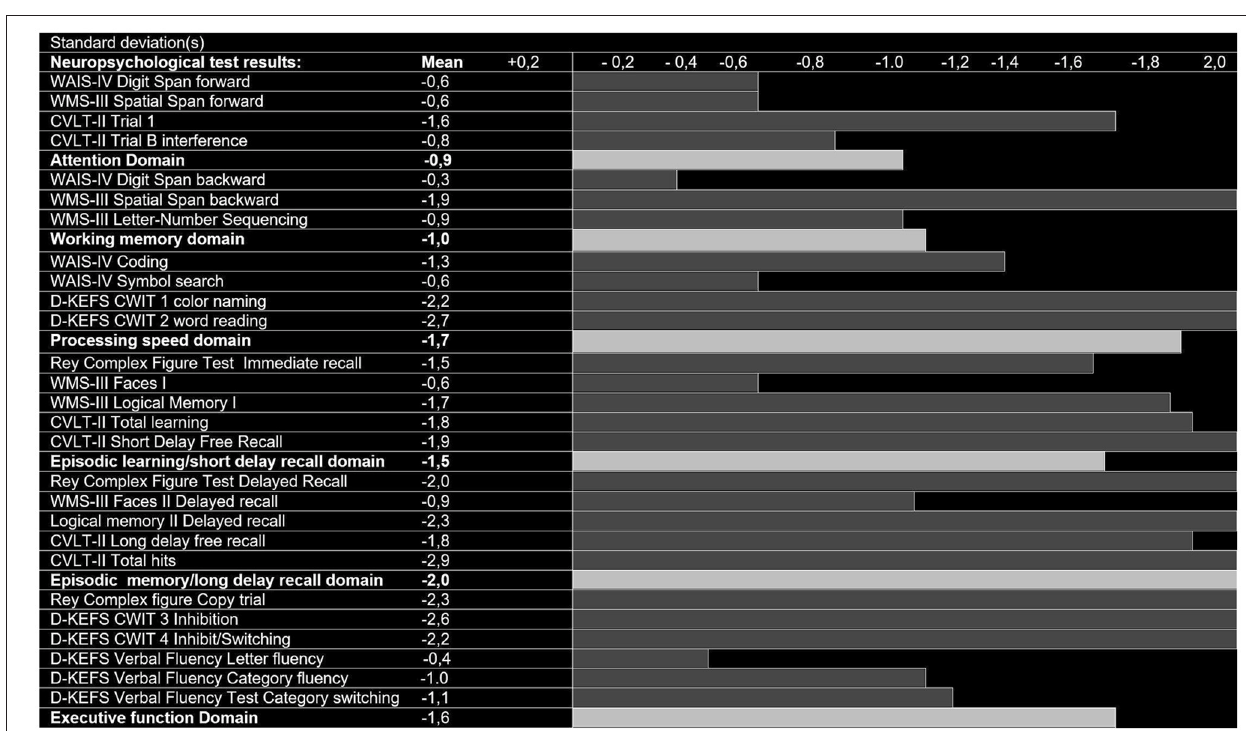
FIGURE 2 | Neuropsychological test results (SD below zero), control group-derived z-scores in patients with amnestic Mild Cognitive Impairment (aMCI, n = 35).